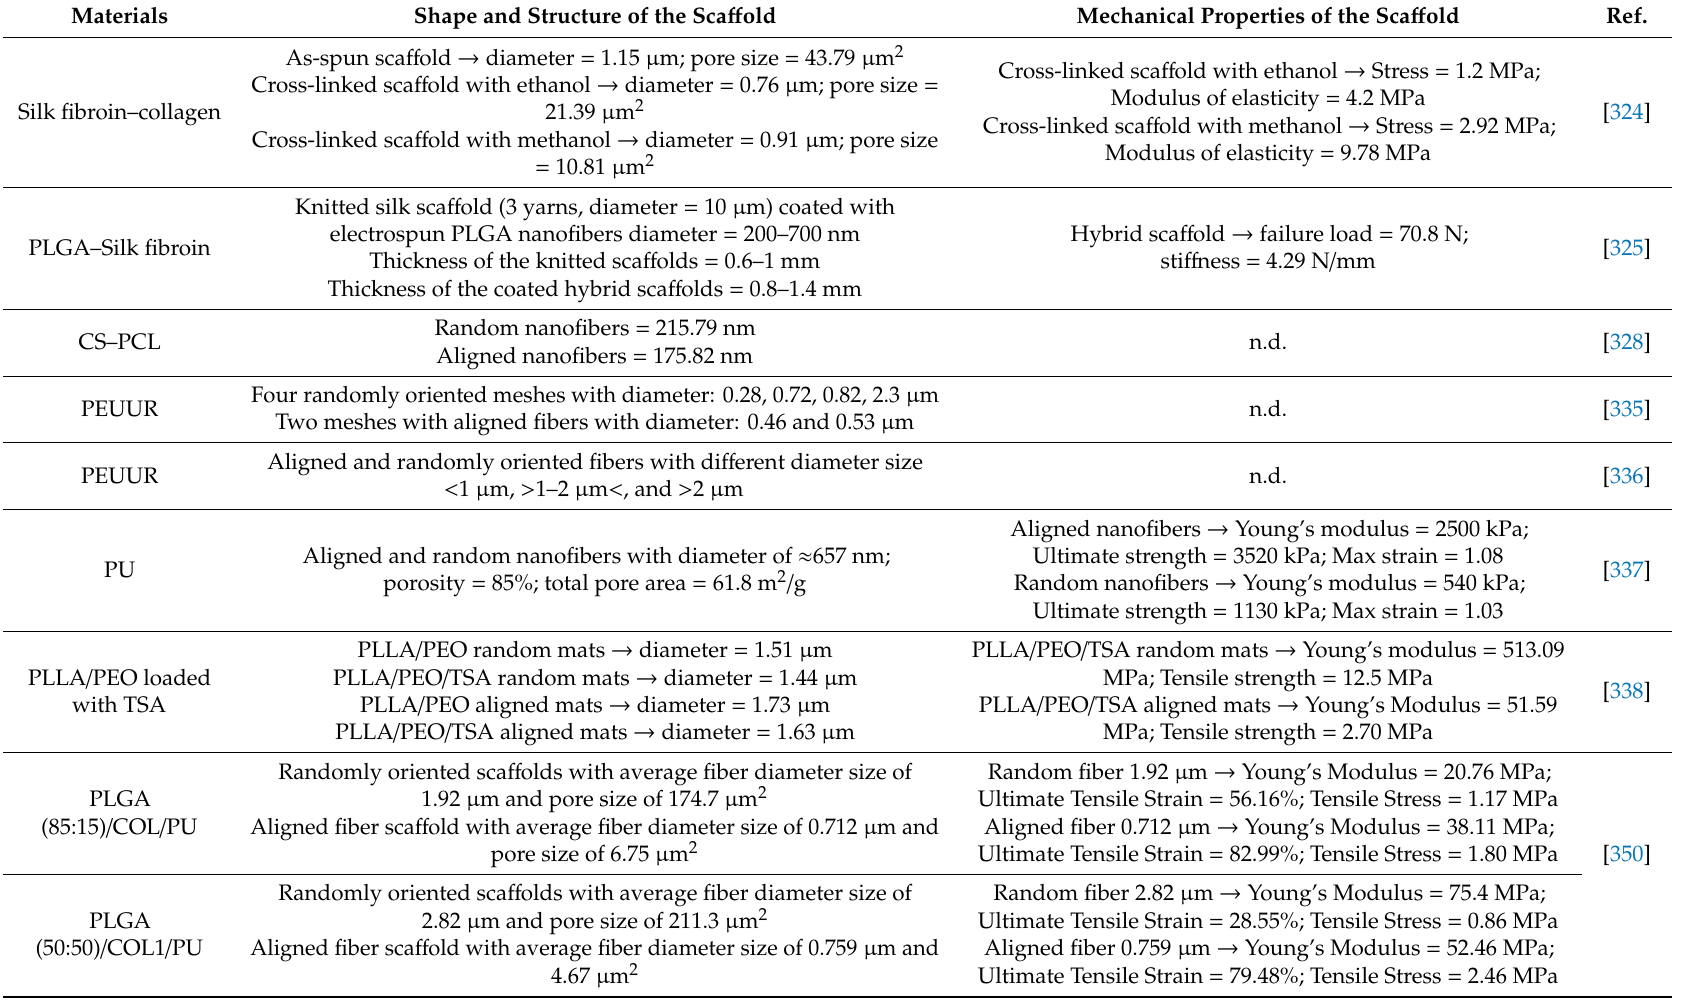
Table 1. Ultrastructure and mechanical matrix properties in tendon tissue